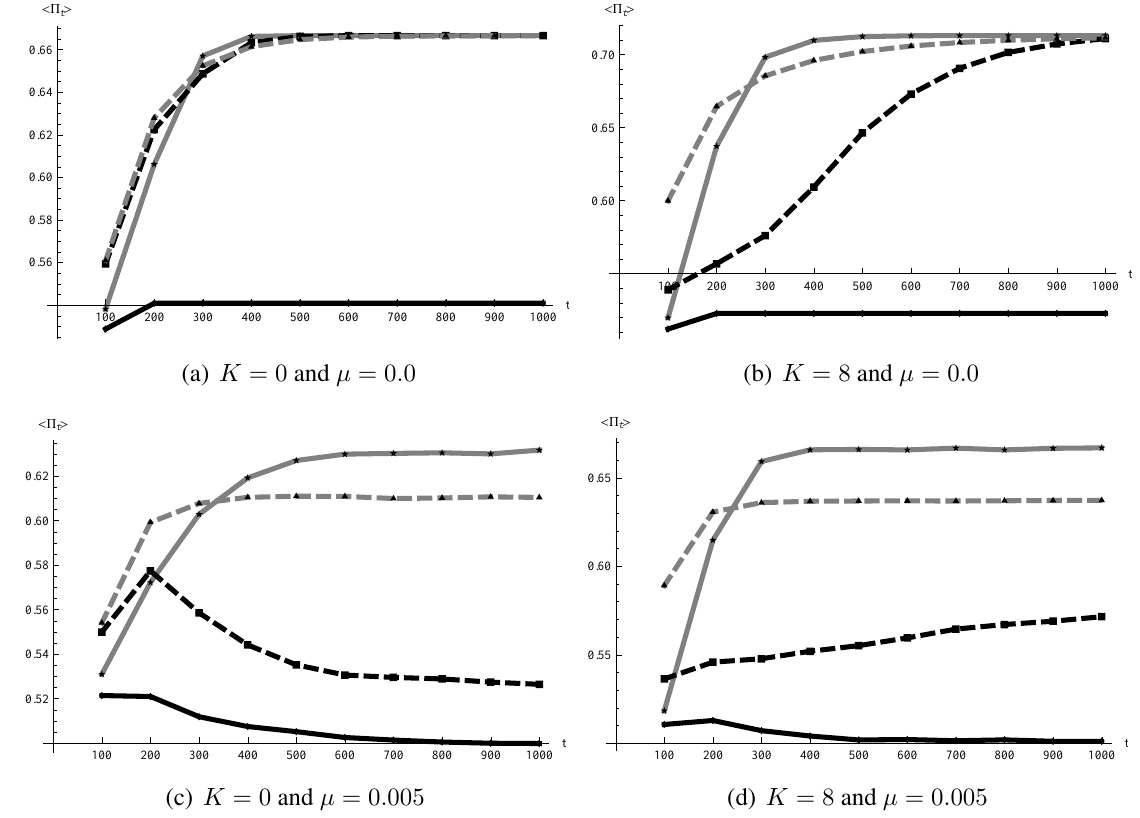
Figure 3. Average performance over time for two levels of complexity, K = 0 ( left ) and K = 8 ( right ) and two degrees of environmental turbulence, µ = 0 . 0 ( top ) and µ = 0 . 005 ( bottom ). Four values of λ are considered: λ = 0 . 0 (solid black), λ = 0 . 2 (solid gray), λ = 0 . 6 (dashed black) and λ = 1 . 0 (dashed gray). The communication is active ( p = 1 . 0 ). The data is generated by taking the average per period organizational performance for each block of 100 periods. The average from 500 simulation runs is